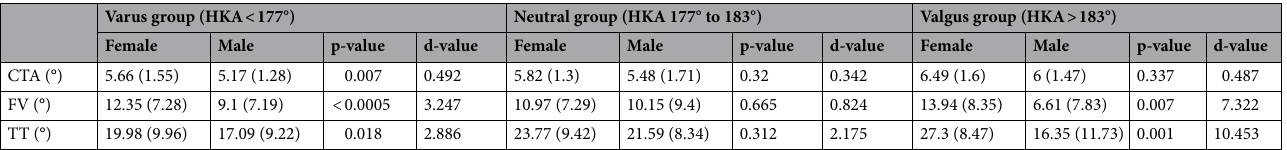
Table 3. Rotational parameters according to gender and to the coronal alignment group. Femoral external rotation in our study is significantly higher in females than in males only in the varus coronal alignment group. Femoral anteversion and tibial external torsion are significantly higher in females than males in varus and valgus alignments, but not in neutral alignment (independent two-sample t-test). Angular values expressed as the mean and (standard deviation). CTA condylar twist angle, FV Femoral Version measured between the femoral neck axis and the posterior condylar line, HKA hip-knee-ankle angle, TT Tibial Torsion. d-value to qualify the magnitude of an effect (the difference between means) can be interpreted according to the criteria by Hopkins et al. 21 : less than 0.2, trivial; 0.2–0.59, small; 0.6–1.19, moderate; 1.20–2, large; 2–3.99, very large, and greater than 4, extremely